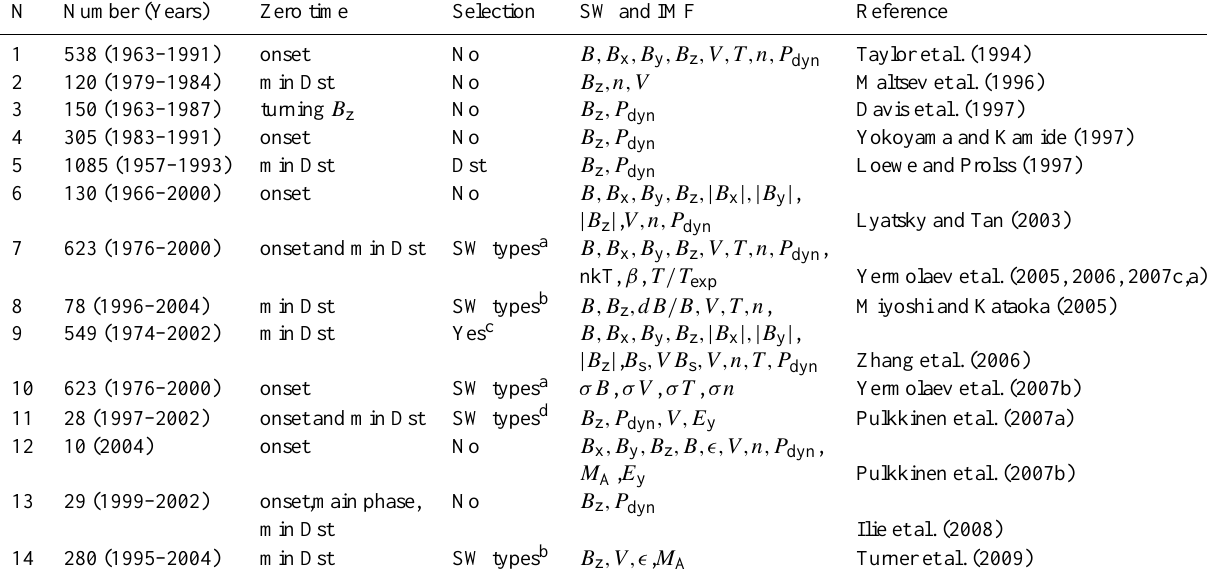
Table 1. List of results on interplanetary conditions resulting in magnetic storms obtained by superposed epoch